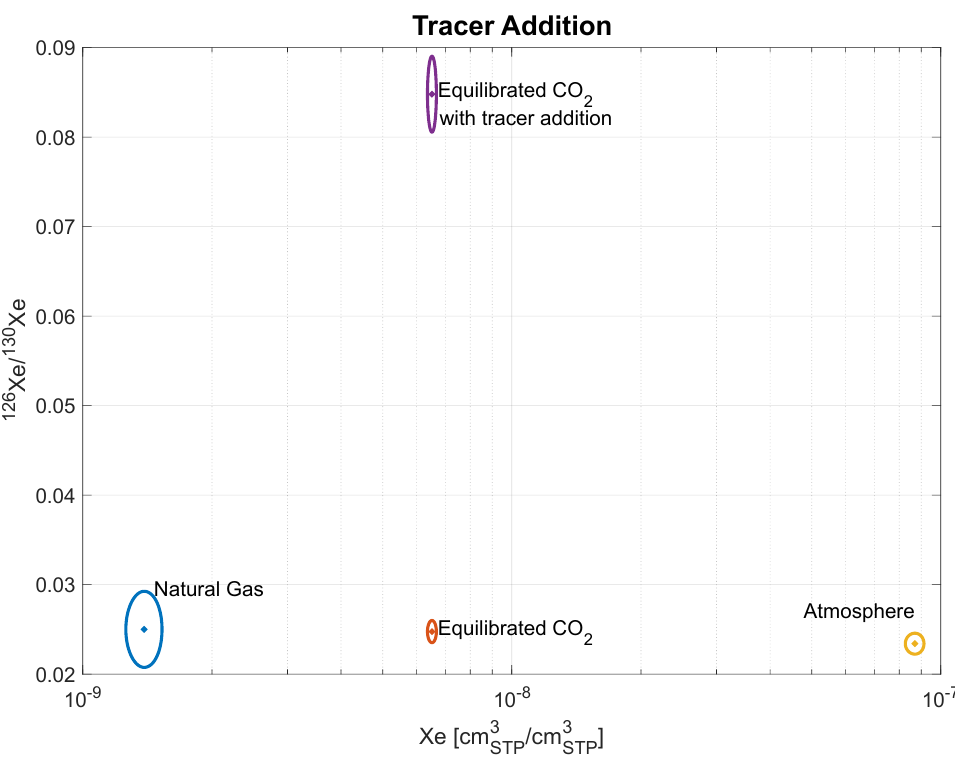
Figure 4. The impact of tracer addition: The signatures of natural gas, equilibrated CO 2 , and atmosphere in comparison to the equilibrated CO 2 with tracer addition. The mean concentration is surrounded by the respective error